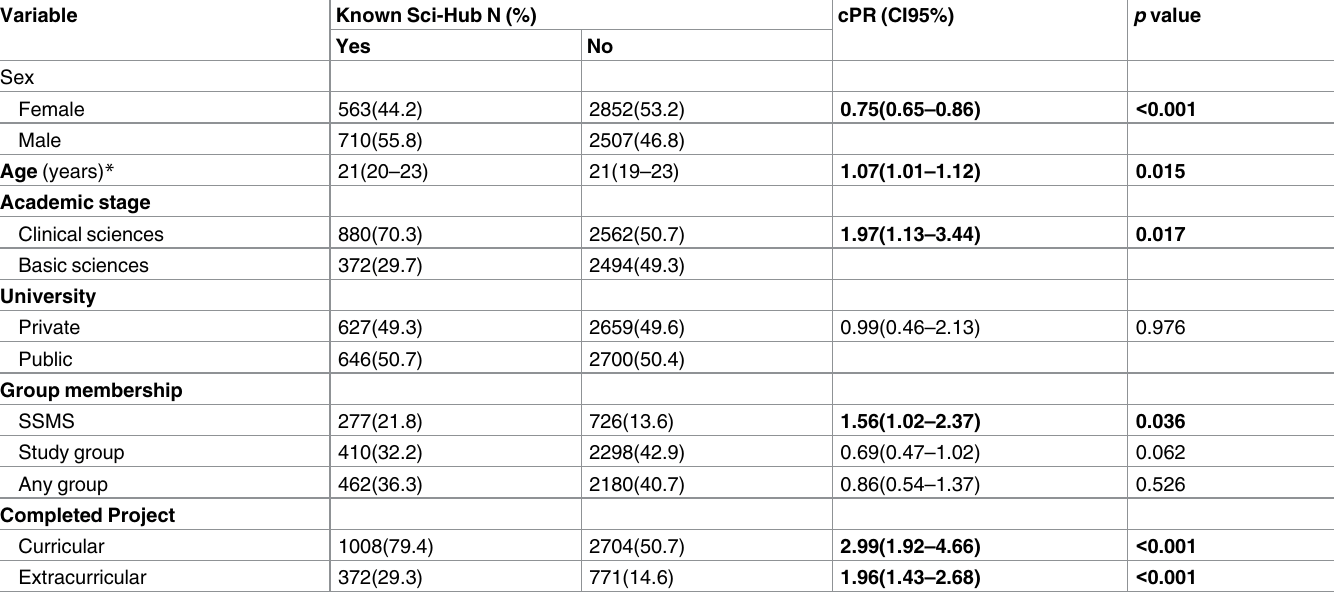
Table 3. Bivariate analysis of knowledge of Sci-Hub among medical students from 6 Latin American countries. Variable